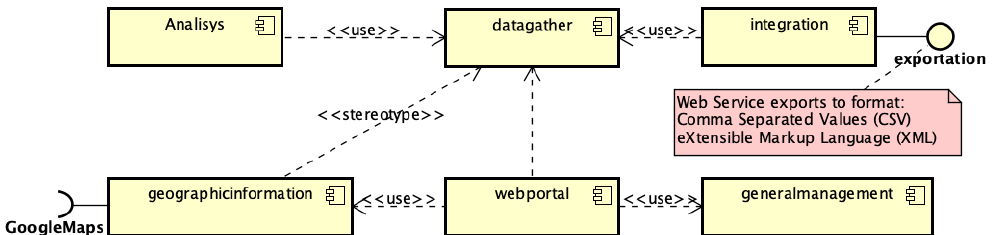
Figure 3. Main modules of the NutriOdonto computing environment. Source: Author’s own